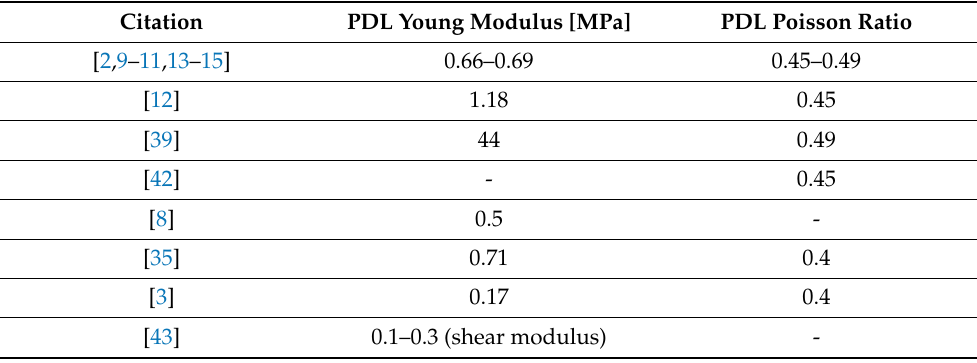
Table 3. Acceptable PDL elasticity modulus and Poisson ratio